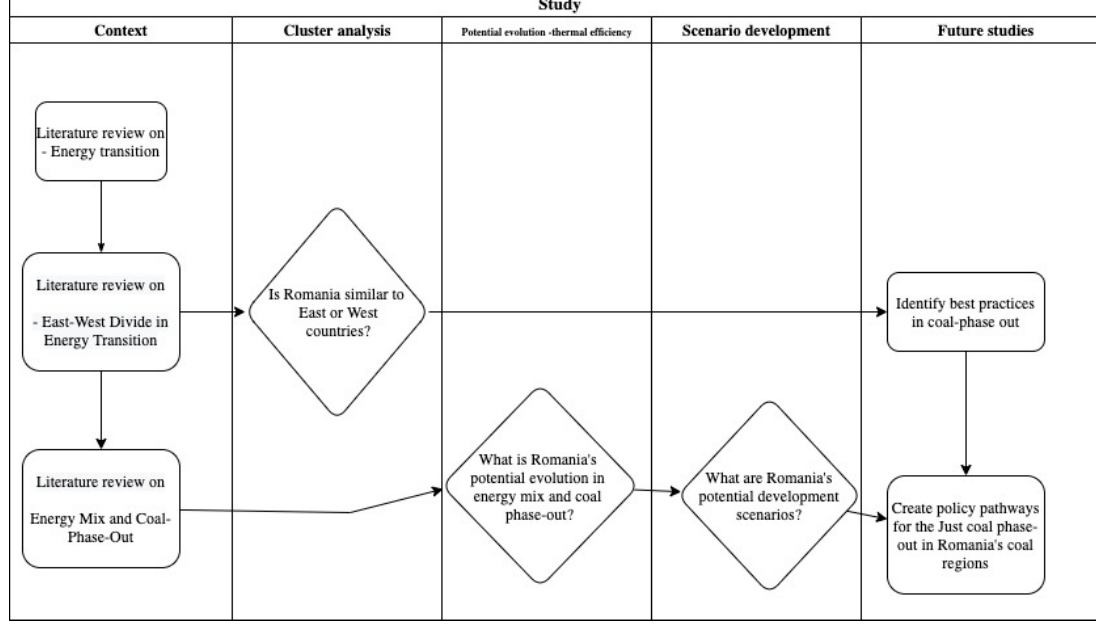
Figure 2. Methodological framework for the analysis—logical diagram.